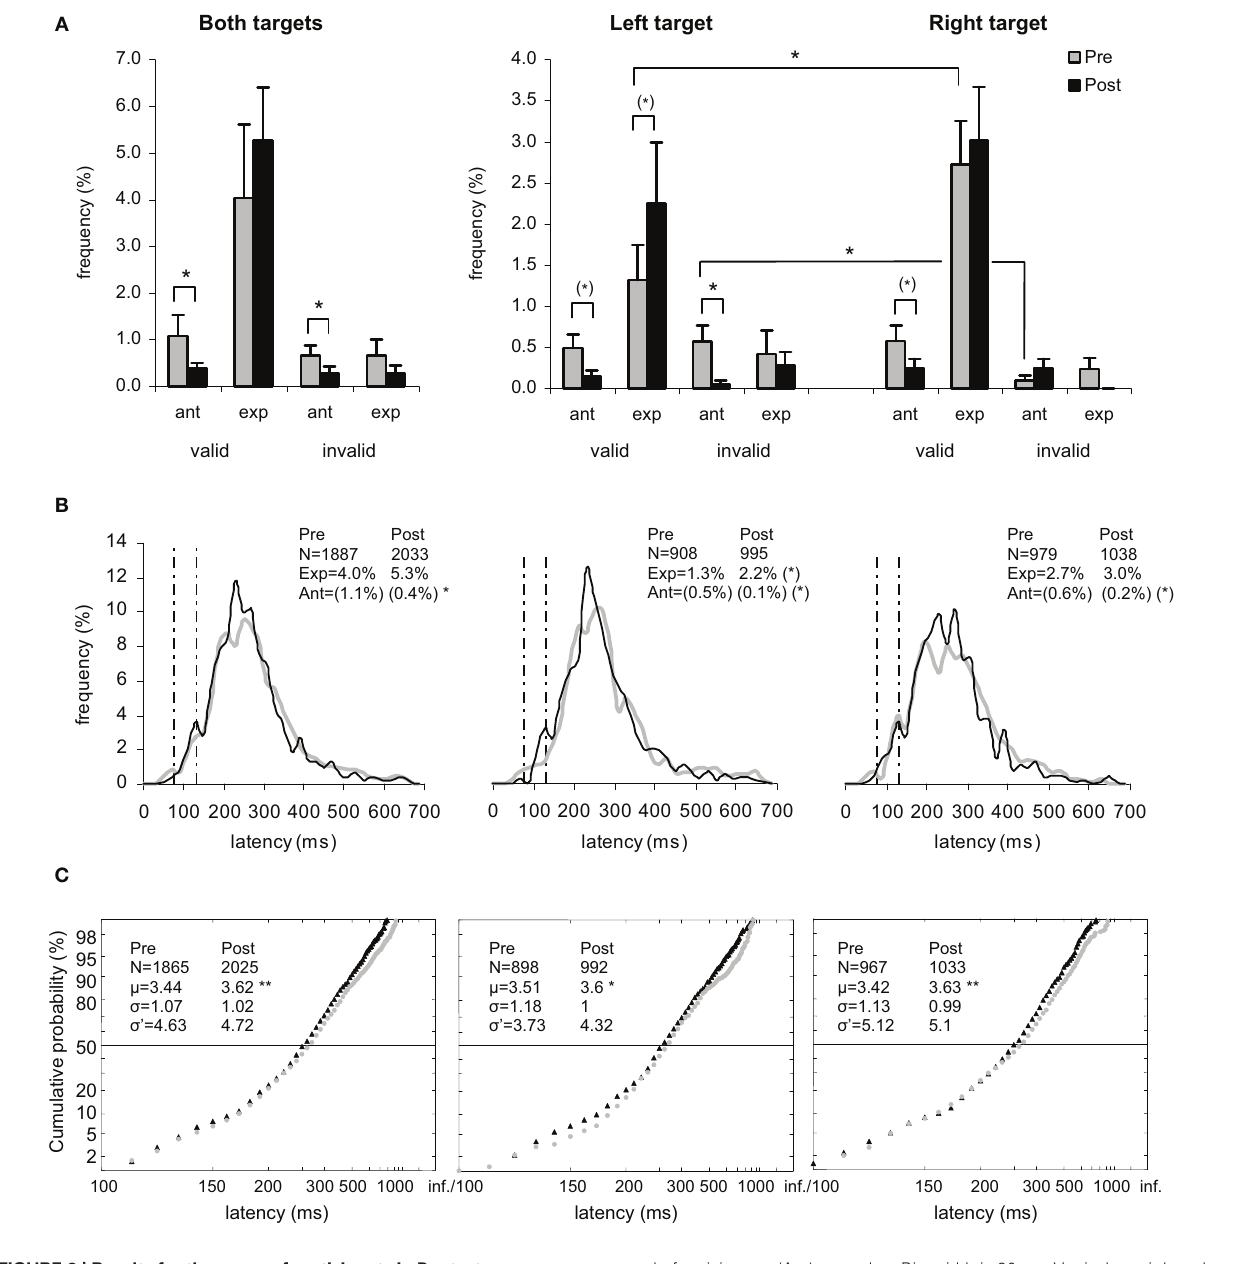
FIGURE 2 | Results for the group of participants in Pre-test (gray) and Post-test (black) periods for Both targets (left panels), Left target (middle panels), and Right target (right panels). (A) Rates of anticipatory (0–80ms) and of express (80–134ms) saccades, separately for valid (i.e., correct responses) and invalid (i.e., errors) directions. (B) Histograms of Frequency (in %) as a function of Latency (in ms) for saccades between 0 and 999ms in valid direction, and rates of express (Exp)